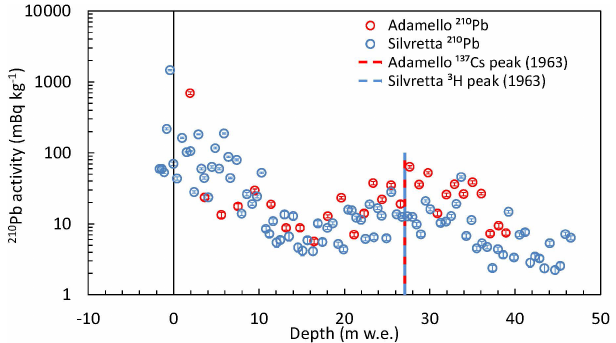
Figure 4. 210 Pb profiles of the ADA16 (on Adamello glacier) and Silvretta ice cores, aligned by shifting the Silvretta depth scale by − 1.8mw.e. to match the 1963 horizon observed in both